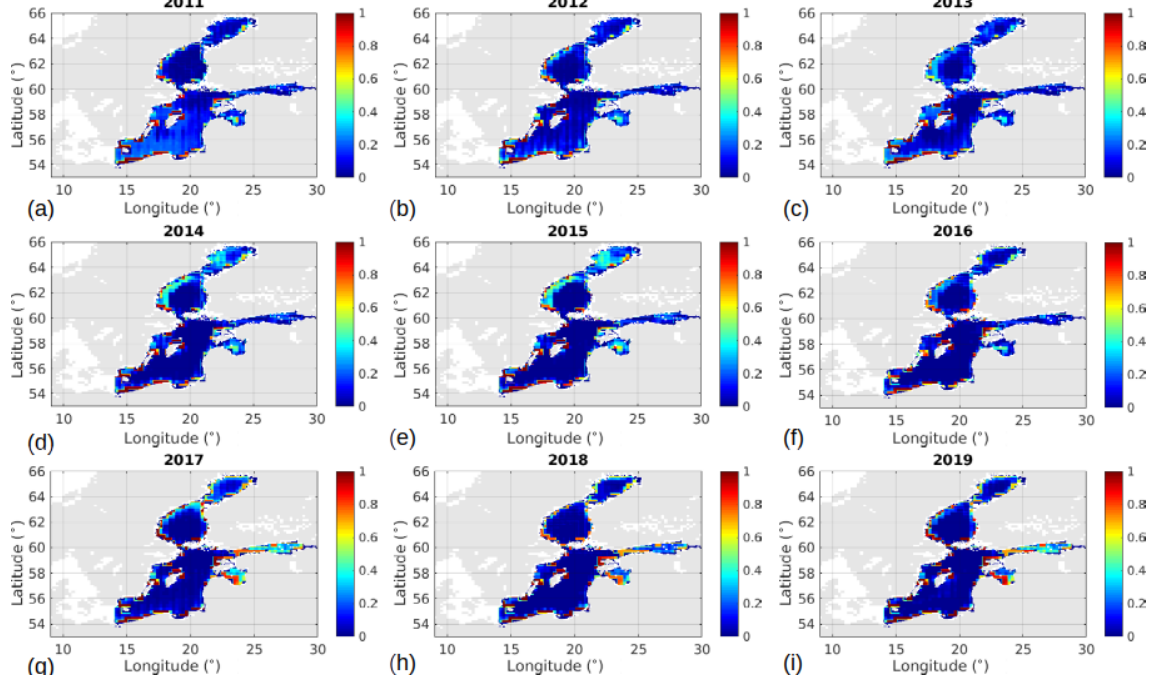
Figure 10. Ratio of time when the SSS from CMEMS Baltic reanalysis is used in those grid points where the SMOS SSS L3 product is not available (from a 2011 to i